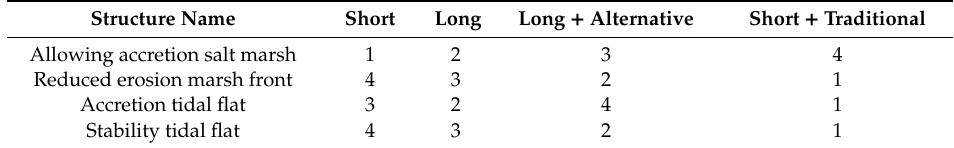
Table 3. Qualitative ranking of how well the artificial structures can steer specific morphological development. Structure Name